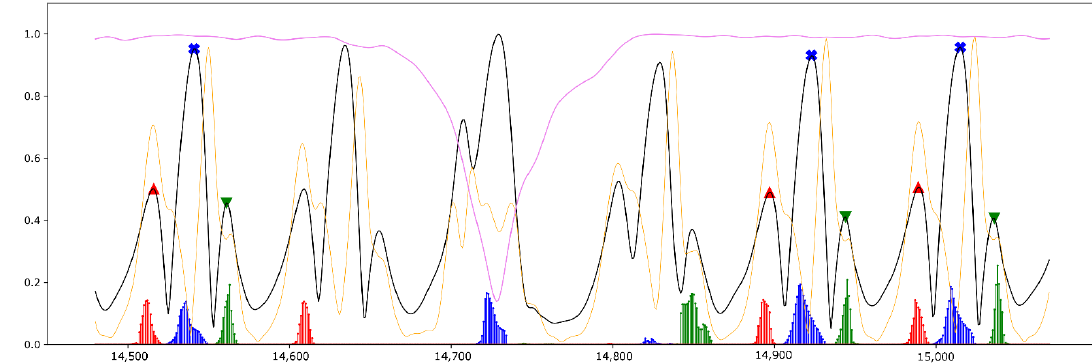
Figure 6. A short part of the prediction results from Test_2_H. This figure demonstrates six steps from the beginning of walking till the last step before turning at the end of the walking track. Black line: smoothed AngVelMag; orange line: smoothed FreeAccMag; violet line: smoothed RotMatMag, red markers: labeled FO; red vertical lines: predictions for FO; blue markers: labeled MidS; blue vertical lines: predictions for MidS; green marker: labeled FC; green vertical lines: predictions for FC.